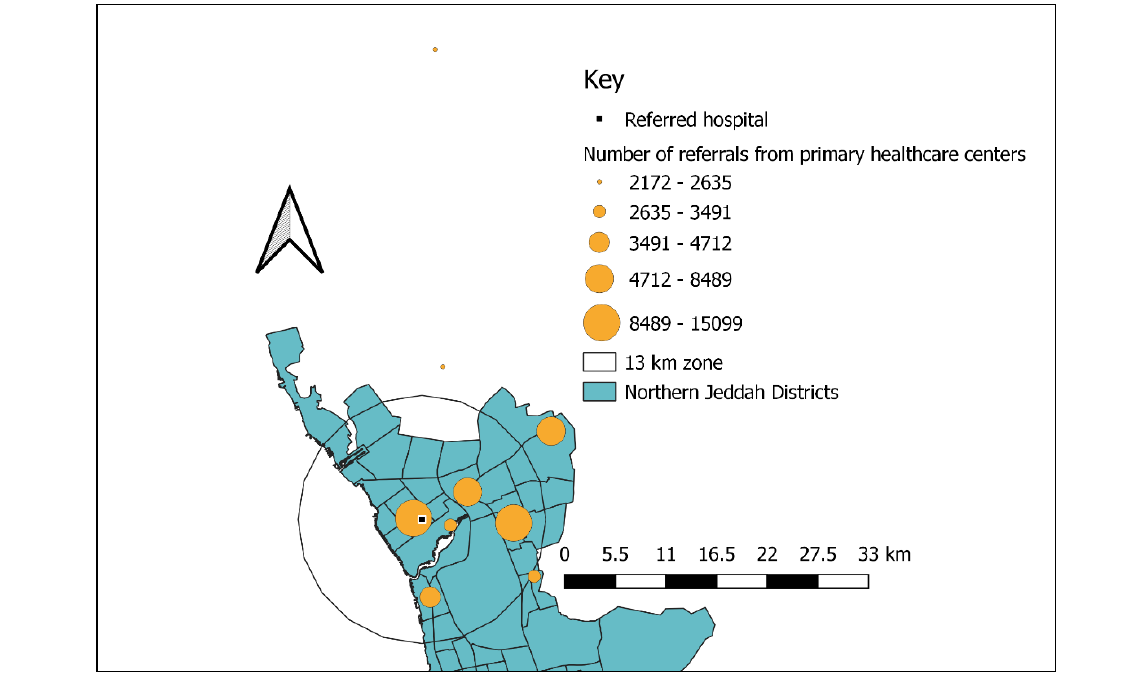
Figure 2. Distribution of referrals based on the primary healthcare service’ distance from a referred hospital between 2019 and 2021 ( n = 52,143).